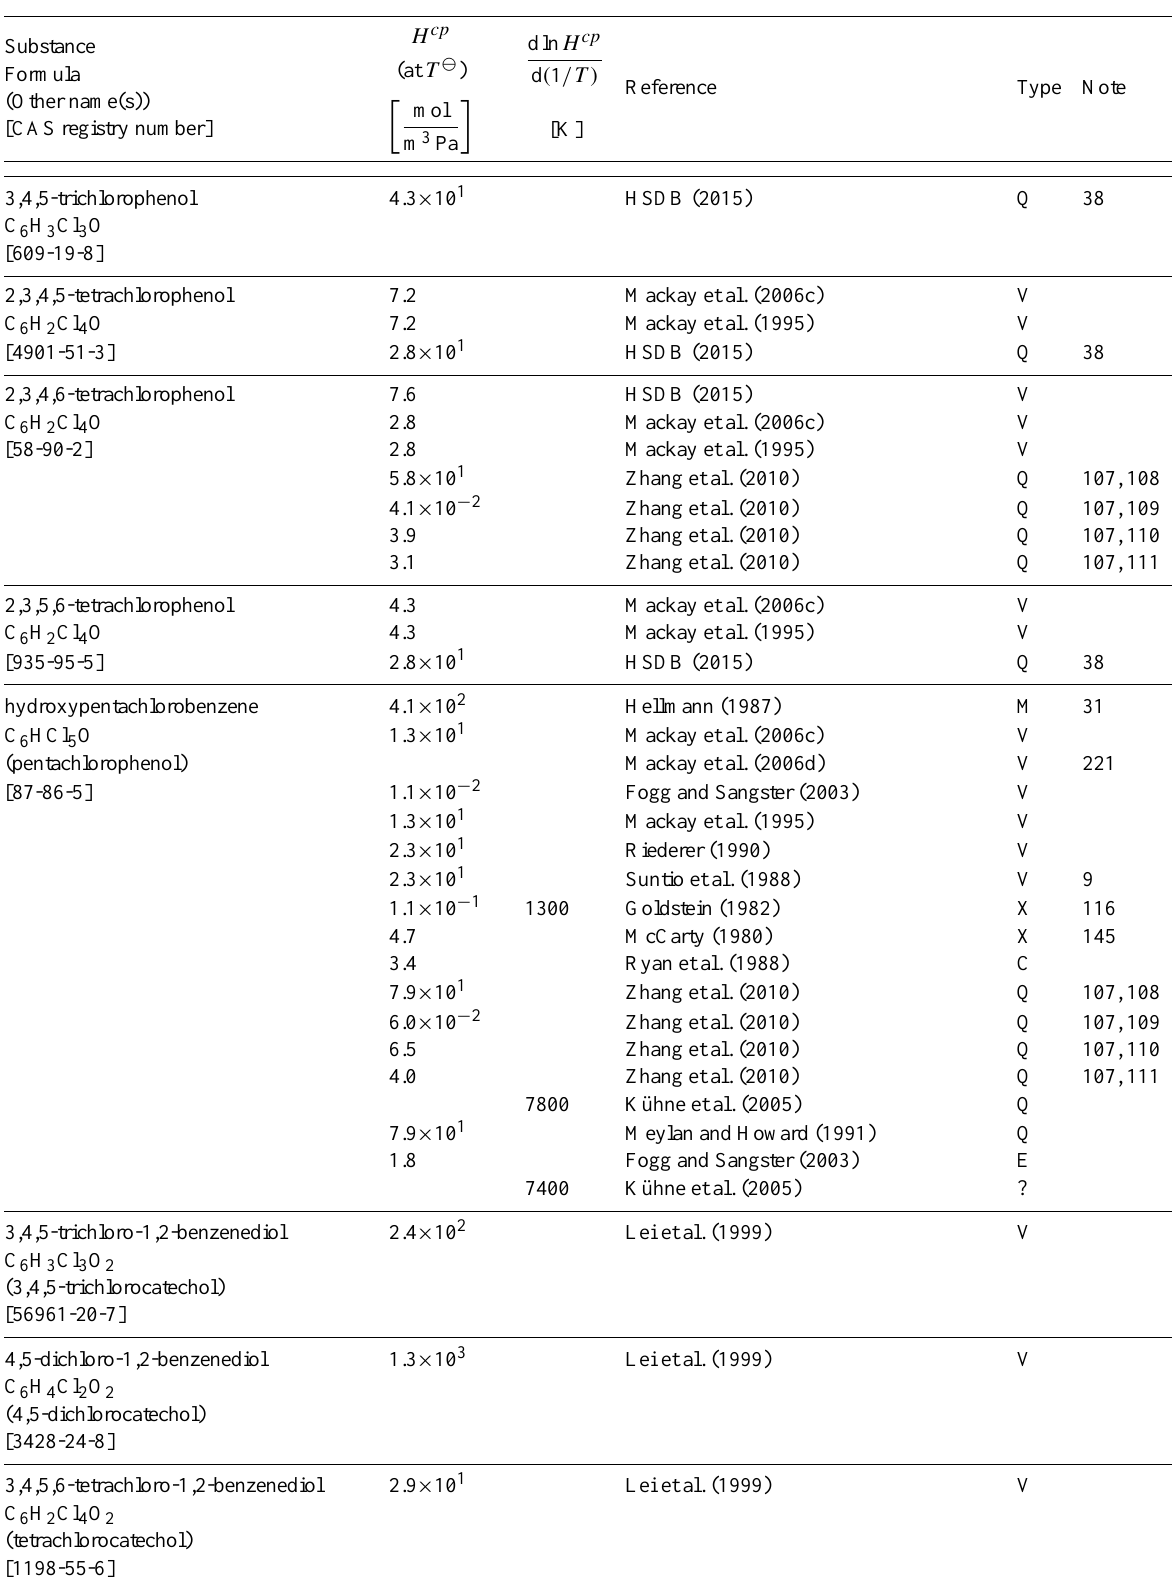
Table 6: Henry’s law constants for water as solvent